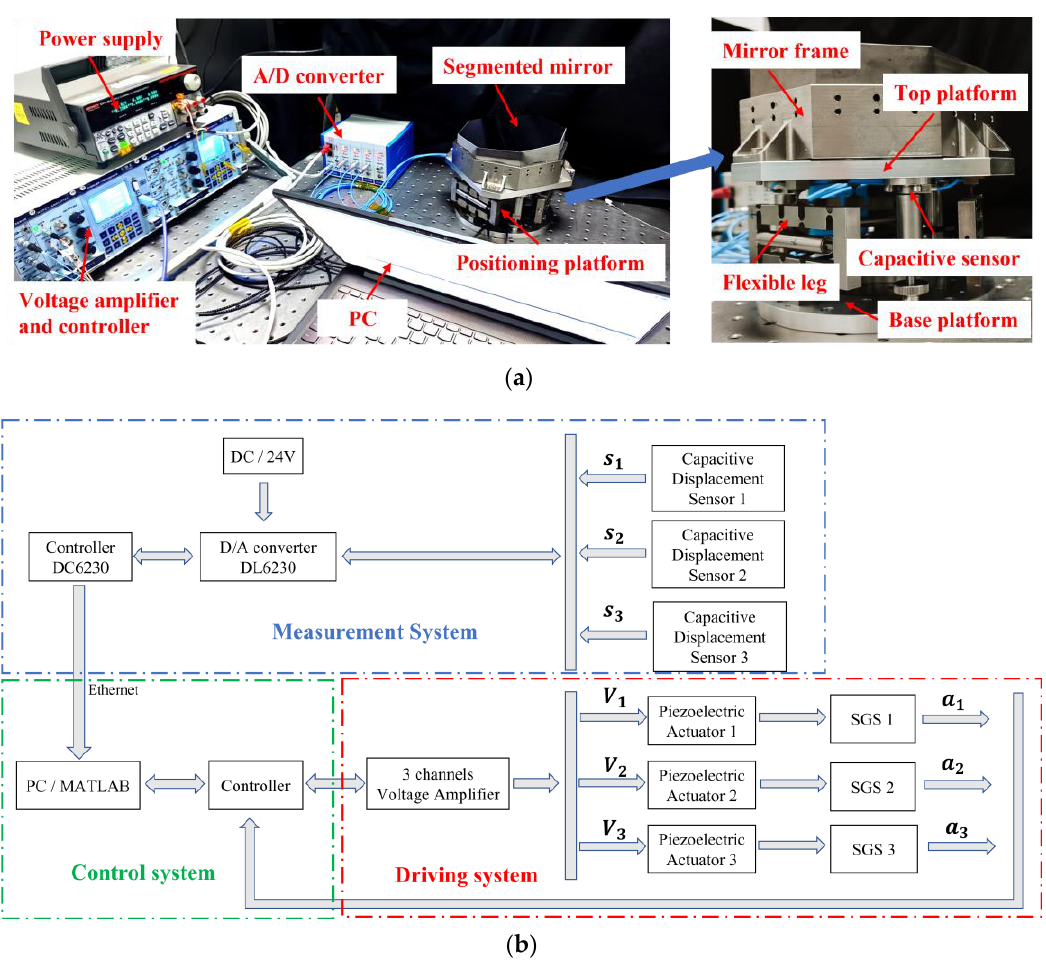
Figure 13. ( a ) Experimental system for 3 − DOF piezoelectric positioning platform. ( b ) Schematic diagram of experimental system.